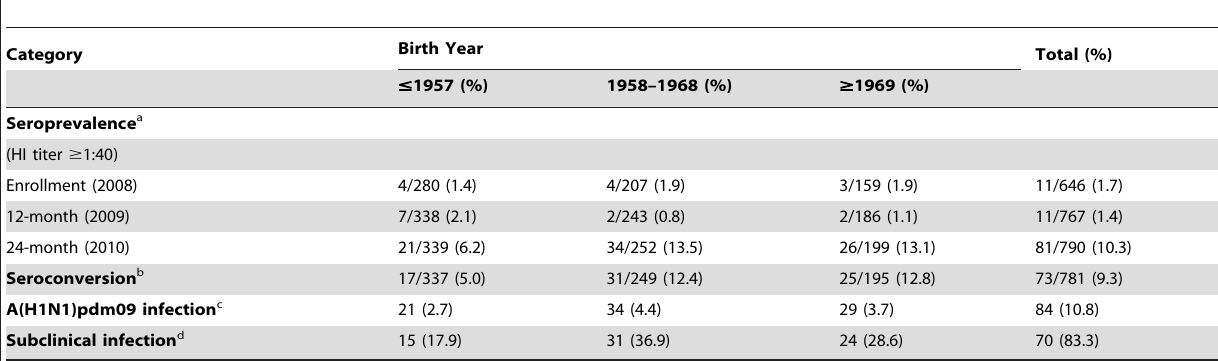
Table 1. Evidence of A(H1N1)pdm09 infection among cohort subjects, Kamphaeng Phet,